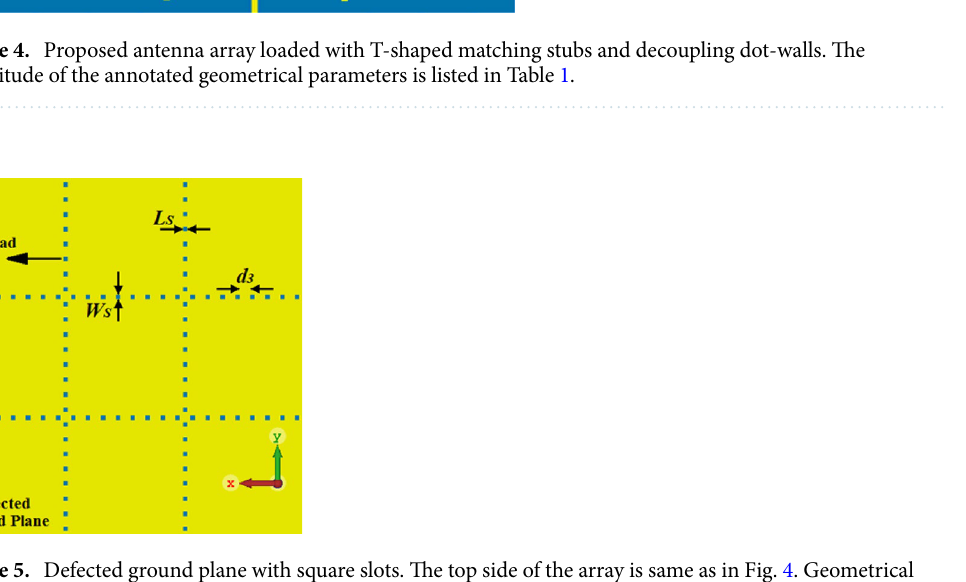
Figure 5. Defected ground plane with square slots. The top side of the array is same as in Fig. 4. Geometrical parameters of the array are given in Table 1.